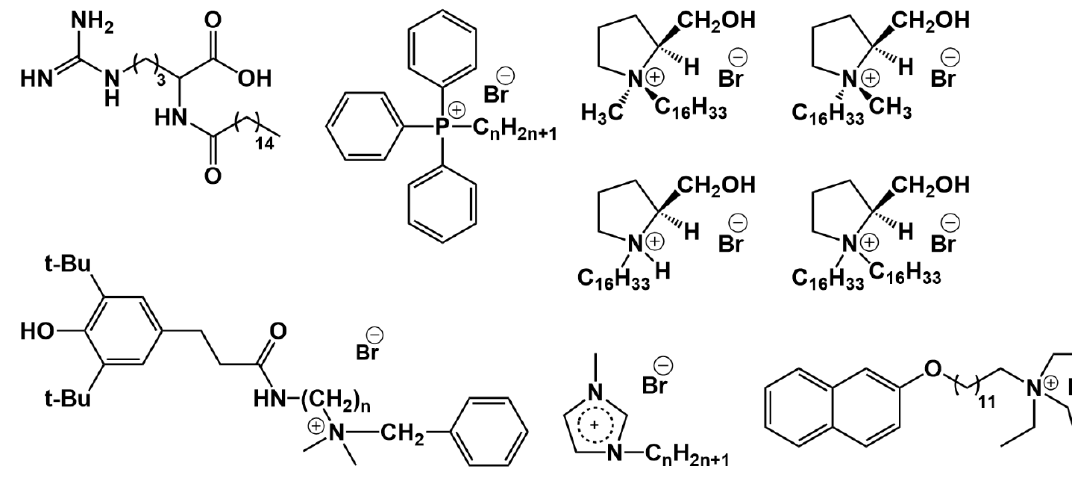
Figure 11. Structural formulas of single-tailed cationic surfactants.